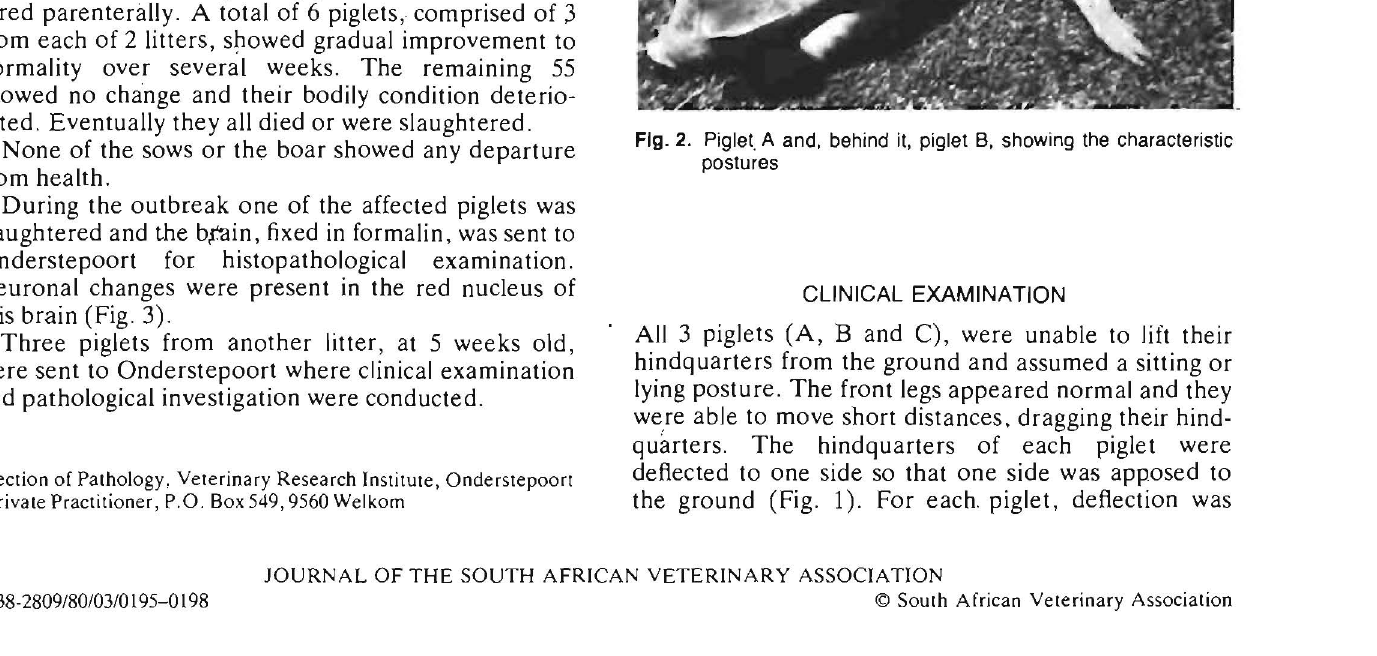
FIg. 2. Piglet. A and, behind it, piglet B, showing the characteristic postures